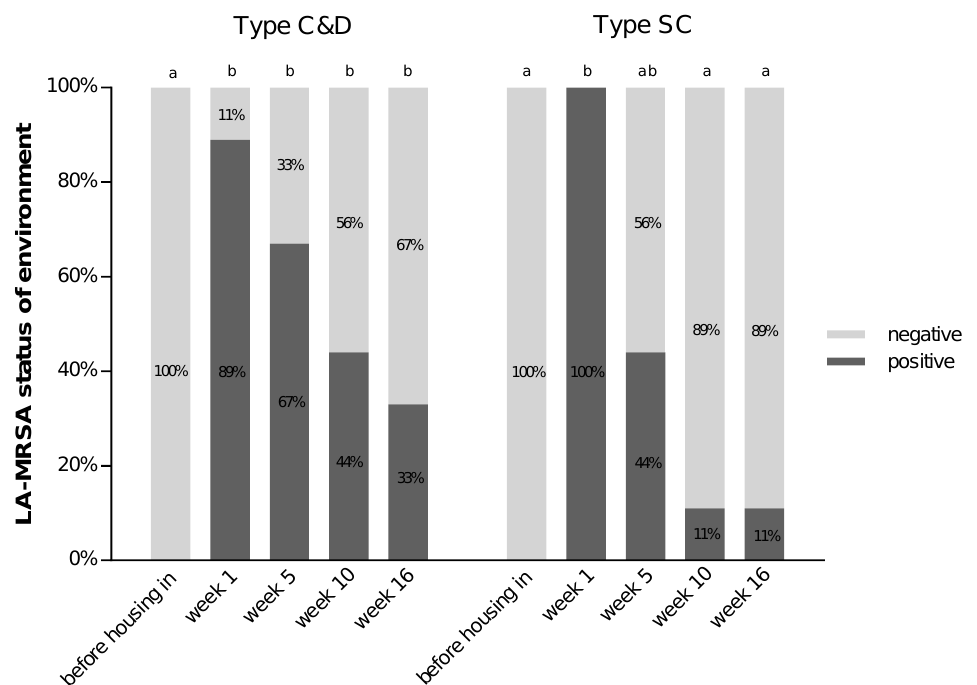
Figure 2. Percentage of LA-MRSA positive and negative environmental samples (surfaces, without straw samples) in type C&D ( n = 55) and type SC ( n = 55) during fattening period; Cochran’s Q Test, significant differences are indicated by letters (a, b) ( p < 0.01).